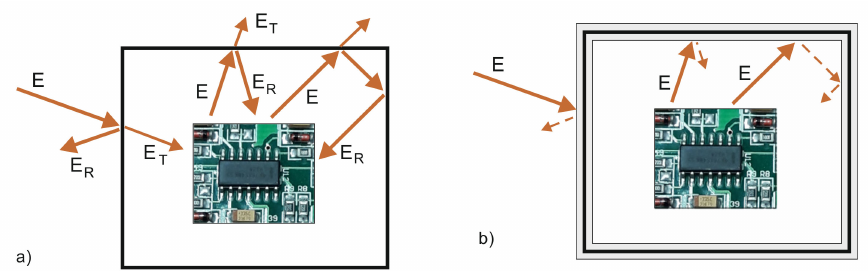
Figure 1. Schematic presentation of incident (E), transmitted (E T ) and reflected field (E R ): ( a ) electronic circuit inside metallic or metallic-like enclosure, ( b ) enclosure equipped with an